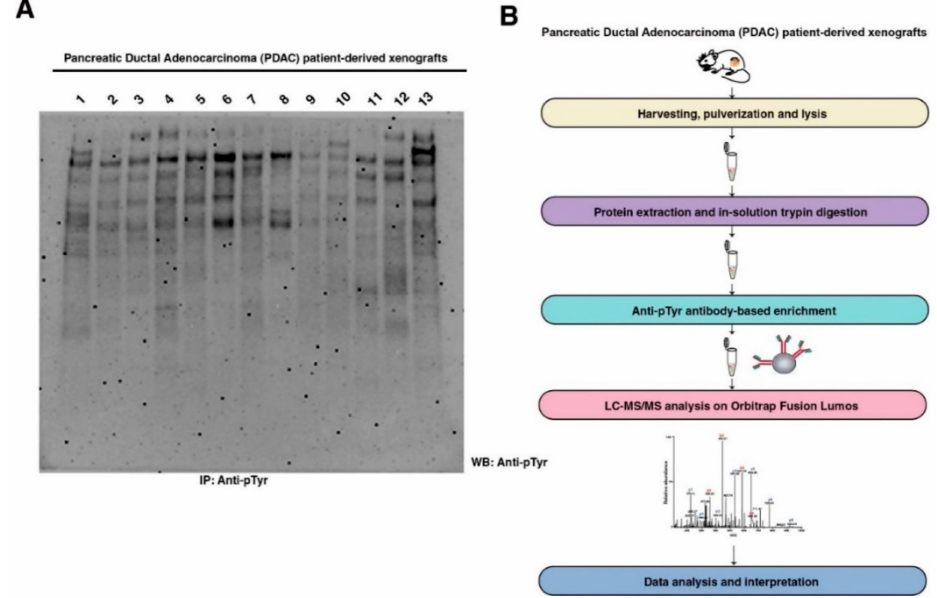
Figure 1. Phosphotyrosine profiling of pancreatic ductal adenocarcinoma (PDAC) patient-derived xenografts (PDXs): ( A ) Global phosphotyrosine characterization of PDAC PDX samples using im- munoprecipitation and Western blot with anti-phosphotyrosine antibody (Clone 4G10); ( B ) Thirteen PDXs were pulverized in liquid nitrogen followed by protein extraction using 9 M urea lysis buffer in 20 mM HEPES (pH 7.4) containing phosphatase inhibitors. Twenty-five mg protein from each PDX sample was subjected to in-solution trypsin digestion followed by SepPak C 18 clean-up and lyophilization. Anti-phosphotyrosine antibody was used for immunoaffinity purification of phos- photyrosine peptides, followed by LC-MS/MS